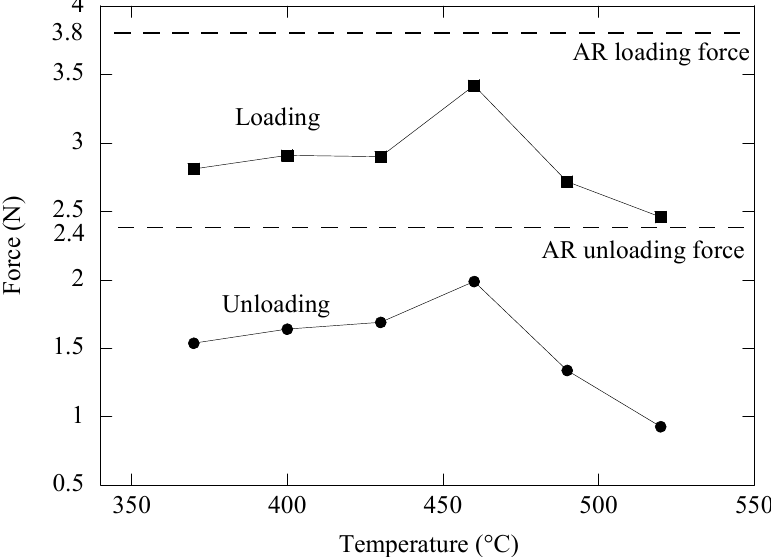
Figure 3. Variation in loading and unloading forces of aged NiTi archwires obtained from the three-point bending test.